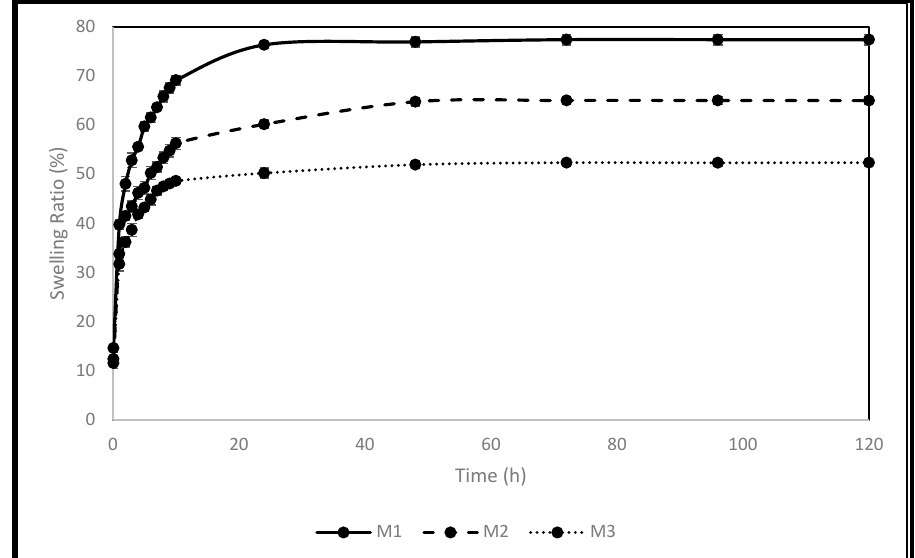
Figure 1. The produced pellets’ swelling behaviour in PBS.